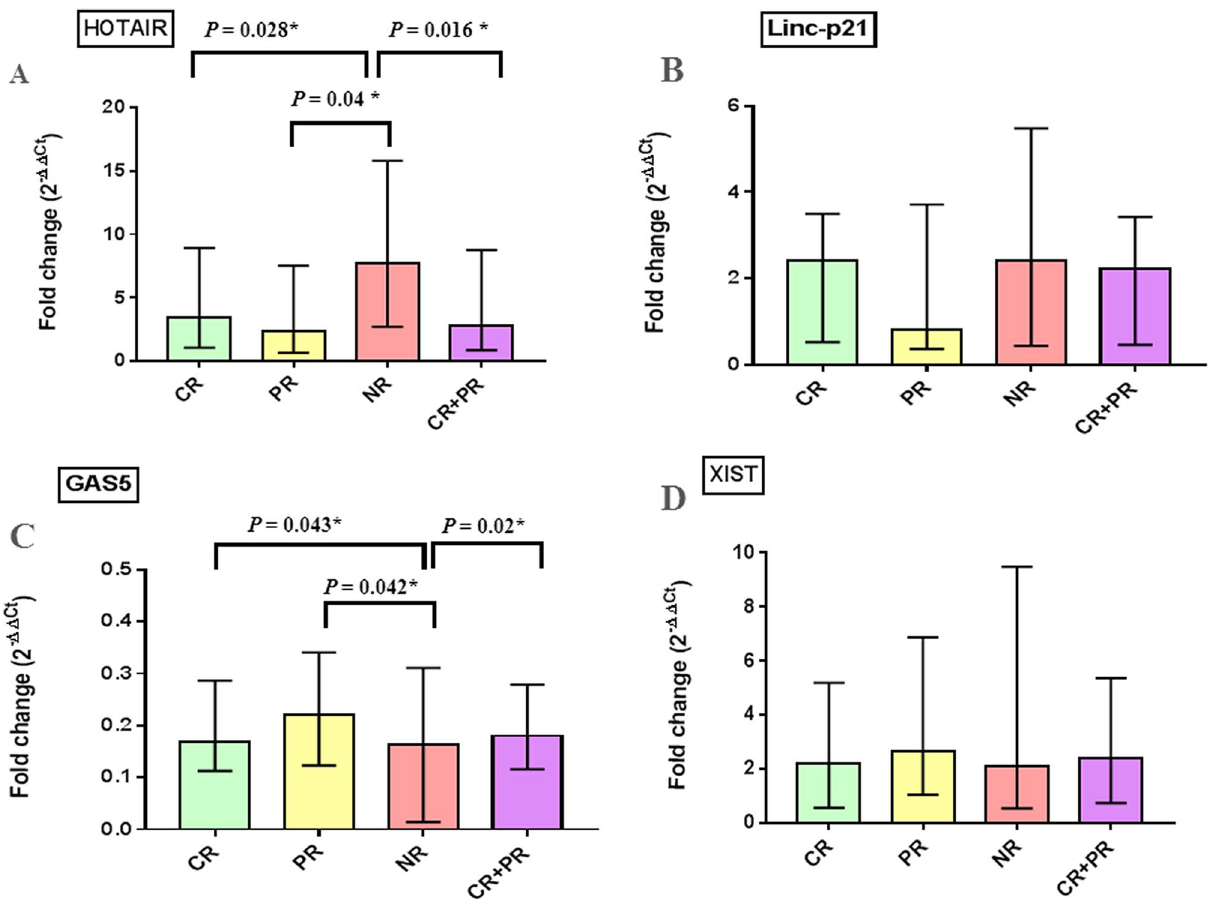
Figure 3. Baseline plasma fold change of studied lncRNAs in relation to treatment response. Data are presented by median interquartile range. Complete response (CR), n = 38, partial response (PR), n = 21 and non- responders (NR), n = 25, overall responders (CR + PR), n = 59. *Indicates statistical significance ( P <